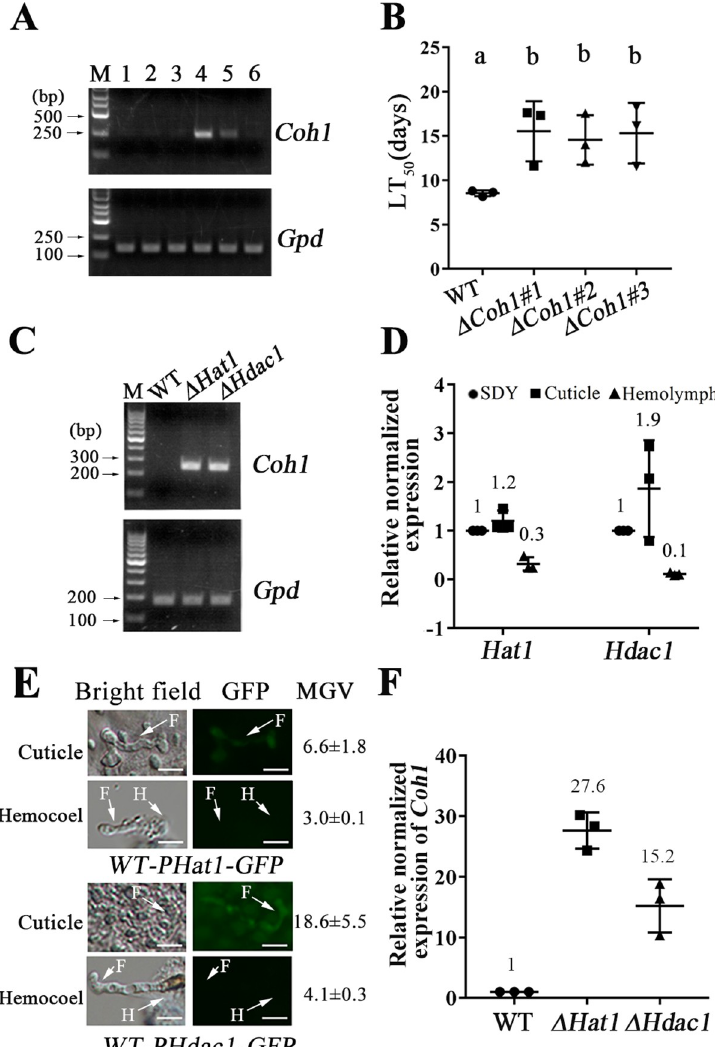
Fig 1. Expression and regulation of the Coh1 gene. (A) Agarose gel electrophoresis of quantitative reverse transcription PCR (qRT-PCR) products of Coh1 . 1: Saprophytic growth in Sabouraud dextrose broth supplemented with 1% yeast extract (SDY) medium; 2: cuticle penetration; 3: colonization of plant roots; 4: growth in the hemocyte- containing hemolymph; 5: live insects infected with M . robertsii ; 6: insect cadavers mummified with M . robertsii mycelium; M: DNA ladder. Images are representative of 3 independent experiments. Upper panel: the gene Coh1 ; lower panel: the reference gene Gpd encoding glyceraldehyde 3-phosphate dehydrogenase. (B) LT 50 (time taken to kill 50% of insects) values when the insects were inoculated by topical application of conidia on the cuticle. Δ Coh1#1 , Δ Coh1#2 , and Δ Coh1#3 are 3 independent isolates of the deletion mutant Δ Coh1 . WT, wild type. The bioassays were repeated 3 times with 40 insects per repeat. Data are expressed as mean ± SE. Values with different letters are significantly different ( n = 3, P < 0.05, Tukey’s test in one-way ANOVA). (C) Agarose gel electrophoresis of qRT-PCR products of Coh1 in WT strain and deletion mutants of the histone deacetylase gene Hdac1 ( Δ Hdac1 ) and the histone acetyltransferase gene Hat1 ( Δ Hat1 ) during saprophytic growth. Note: No qRT-PCR product was seen in the WT strain. (D) qRT-PCR analysis of the expression of Hdac1 and Hat1 in the WT strain during the surrogate hemocoel colonization (Hemolymph) and cuticle penetration (Cuticle) relative to saprophytic growth (SDY). (E) GFP signal in the fungal cells on the cuticle (Cuticle) and in the real hemocoel (Hemocoel) of G . mellonella larvae. The strain with the gfp gene was driven by the promoter of Hat1 (upper panels) or Hdac1 (lower panels). F, fungal cells; H, hemocyte. Scale bar: 10 μ m. Images are representative of 3 independent experiments. The mean gray value (MGV) shows the GFP fluorescence intensity in the fungal hyphae. (F) qRT-PCR analysis of Coh1 expression in the WT strain and the mutants Δ Hat1 and Δ Hdac1 during the surrogate hemocoel colonization. All qRT-PCR experiments in this study were repeated 3 times. For qRT-PCR analyses AU : Pleasecheckthattheeditstothesentence } ForqRT (cid:0) PCRanalyses ::: } intheFig 1 legend ð andthesimilarsentenceinthelegendtoS 1 Fig Þ captureyourmeaning : Ifnot ; pleaseprovidecorrectwording : in this figure, the values represent the fold-change of expression of a gene in treatment compared with expression in its respective control, which is set to 1. The data underlying all the graphs shown in this figure can be found in S1